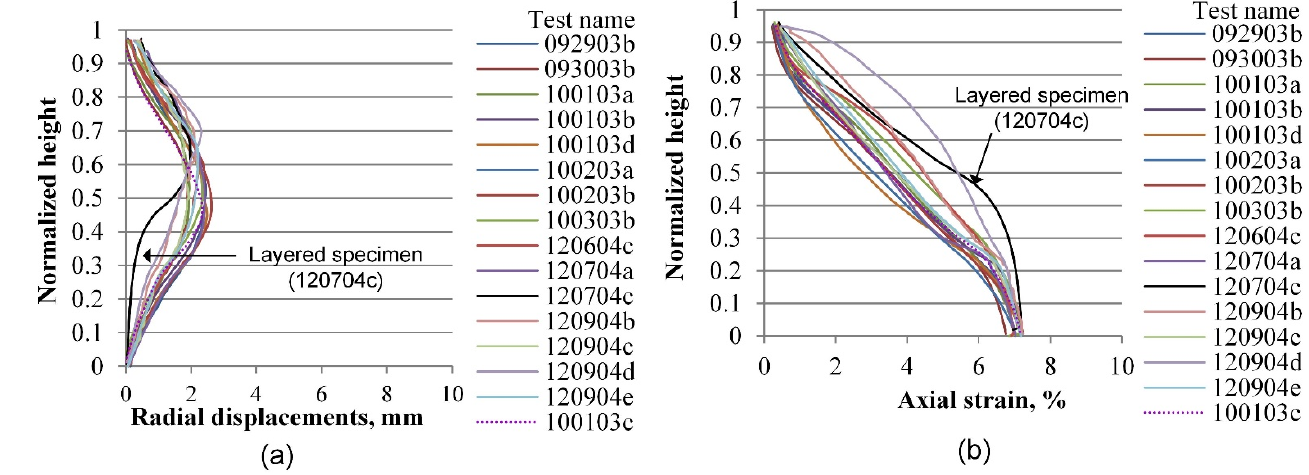
Figure 23. Vertical profiles of averaged displacements at 7.0% of the axial strain of sand specimens prepared by the vibratory compaction method: radial displacements ( a ) and vertical displacements